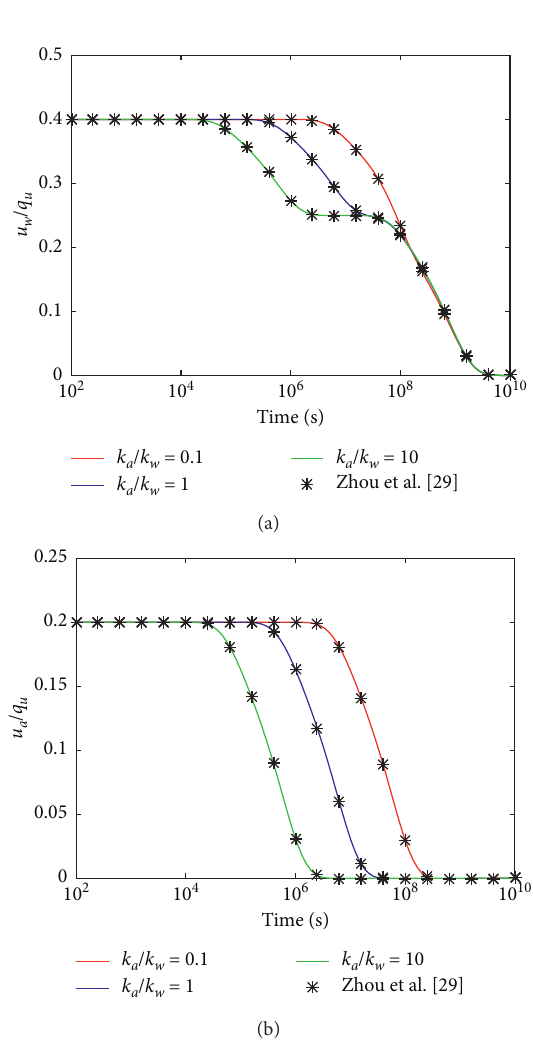
Figure 4: Comparison between the degenerate solution and the existing solution for constant